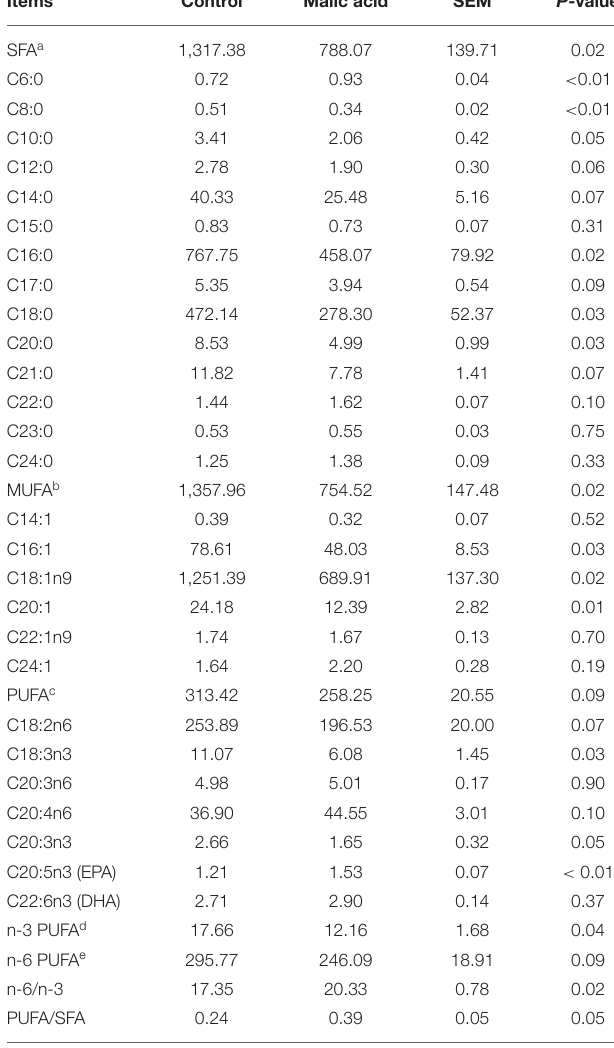
TABLE 3 | Effects of dietary malic acid supplementation in weaned piglets on fatty acid composition of longissimus thoracis muscle of finishing pigs (mg/100g muscle based on wet weight) ( n =